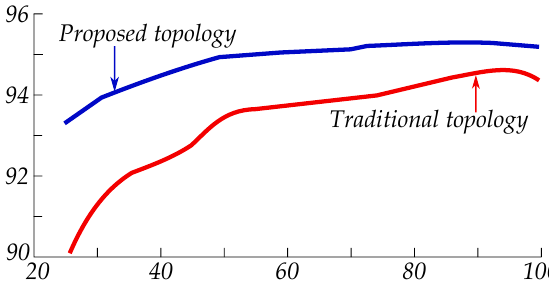
Figure 4. Efficiency compression of the proposed and traditional PFC